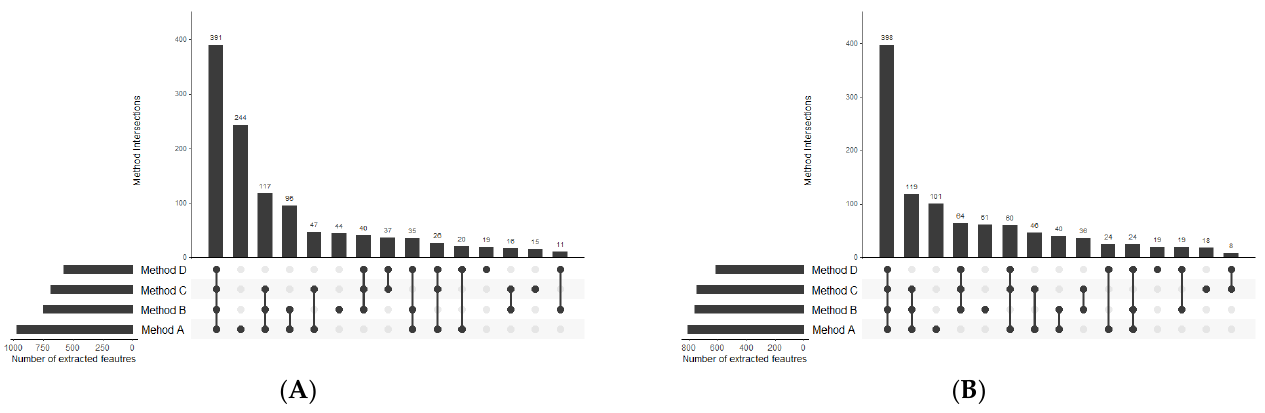
Figure 8. Summary of extraction methods reproducibility based on average CV value of metabolite intensity, calculated based on three replicate extracts. 2.1.3. Metabolite Composition of Organic and Polar Fractions Based on the presented results, method B, relying on two-phase extraction with MTBE, methanol, and water (1.3:1:1.2 v/v ), was chosen as the most appropriate one for untargeted metabolomic analysis of GIST tumour samples. The lipidomic profile obtained using the selected extraction procedure covered several classes of compounds including glycerolipids, ceramides, glycerophosphocholines, glycerophosphoethanolamines, glyc- erophosphoinositols, sterols, fatty acids, fatty aldehydes, and esters, all detected in posi- tive ionization mode. In turn, negative ionization mode enabled detection of ceramides, glycerophosphoinositols, glycerophosphoglycerols, glycerophosphoethanolamines, glyc- erophosphocholines, glycerophosphates, glycerolipids, and fatty acids. In polar extracts, metabolites from various chemical groups and biochemical path- ways were determined. In positive ionization mode, a considerable fraction of detected compounds belonged to amino acids and their derivatives. Among other metabolites, nu- merous purines, pyrimidines, acylcarnitines, and a few medium-chain fatty acids were